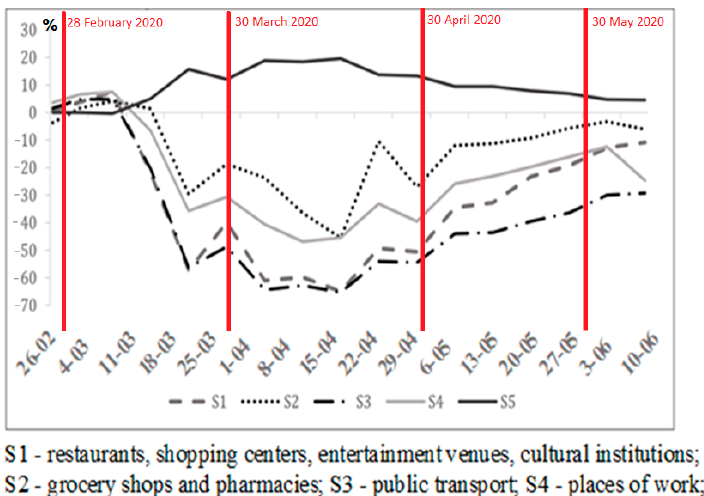
Figure 8. Average weekly changes in mobility in Poland from 20 February 2020 to 14 June 2020. Source: own elaboration based on [76]. Source: own elaboration based on [76].